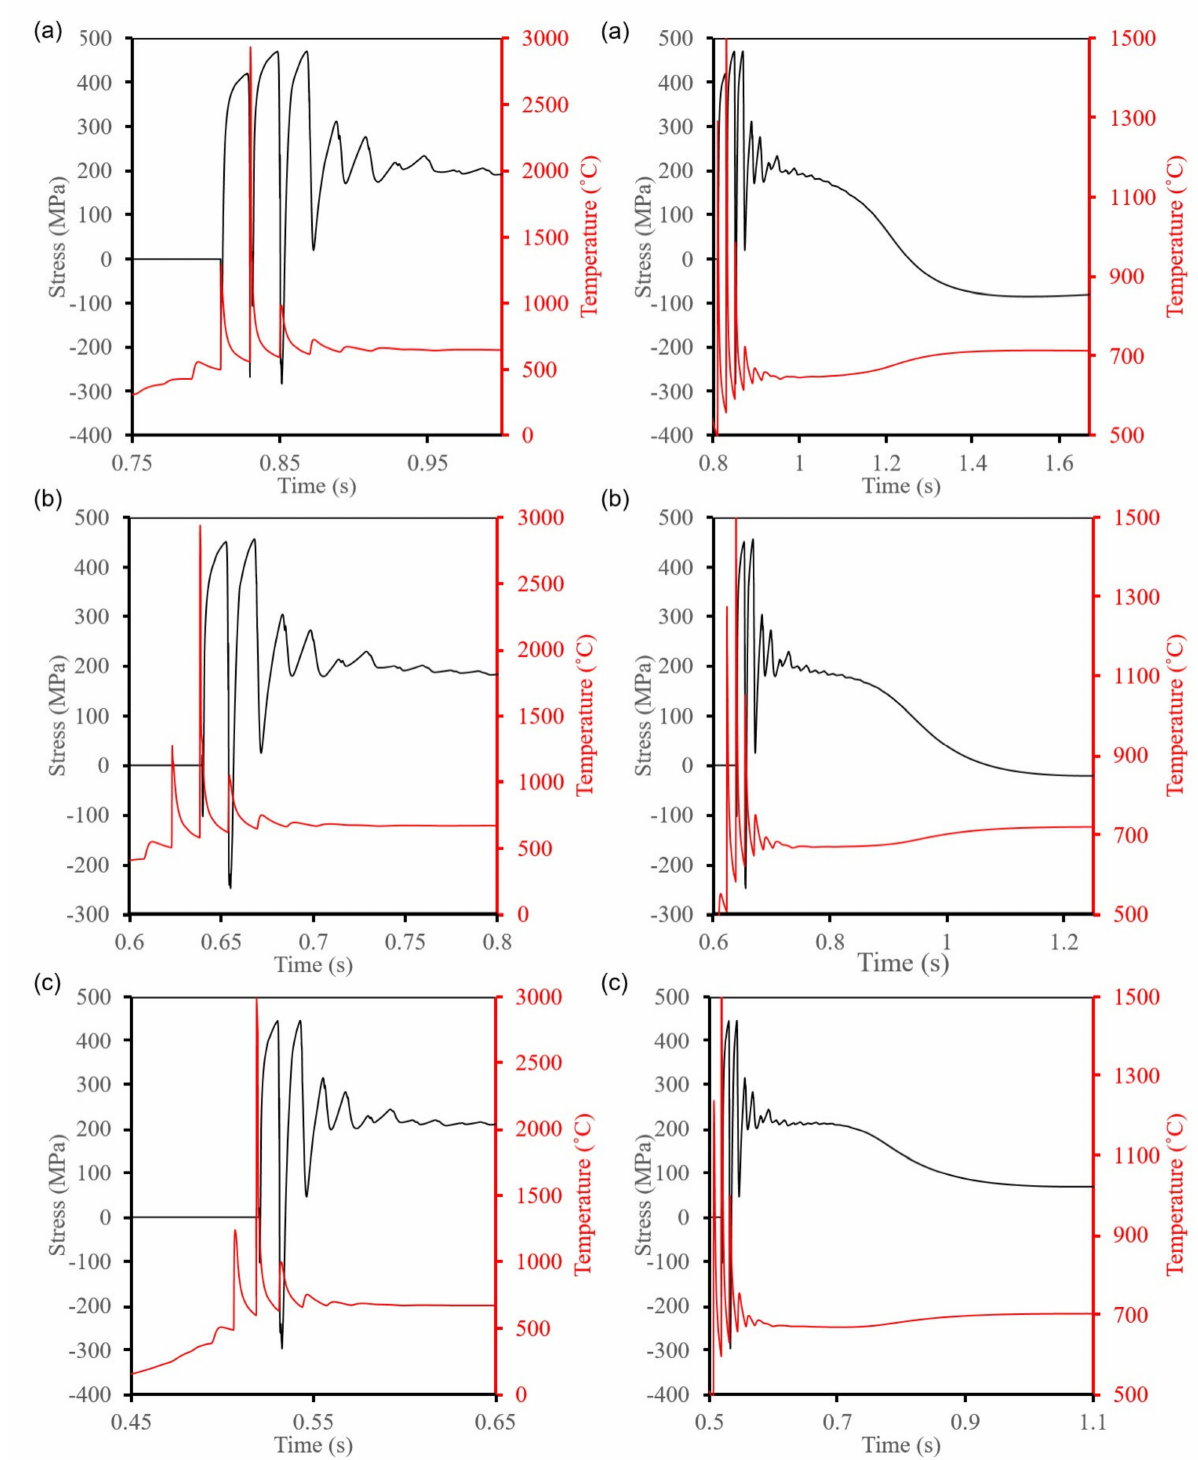
Figure 39. Temperature and stress evolution at energy density 2.82 J/mm 2 at ( a ) 170 W, 500 mm/s, ( b ) 220 W, 650 mm/s, and ( c ) 270 W, 800